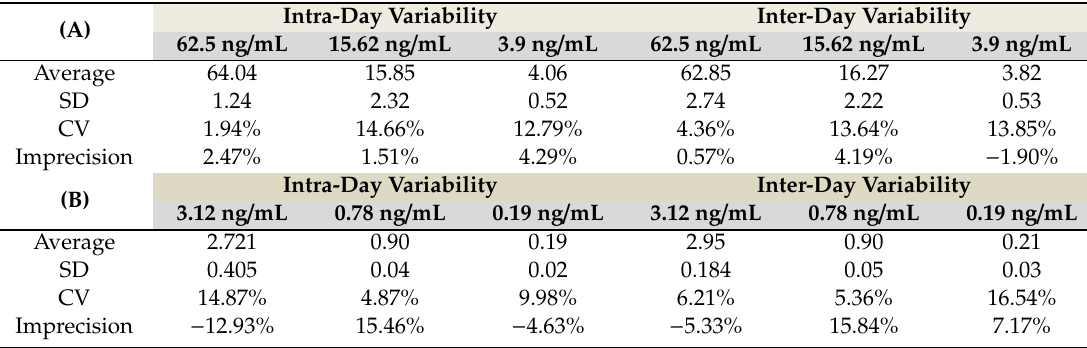
Table 3. Statistical analysis of three di ff erent mAb concentrations to determine the precision of the ( A ) a-PD-1 ELISA; ( B ) a-PD-L1 ELISA.